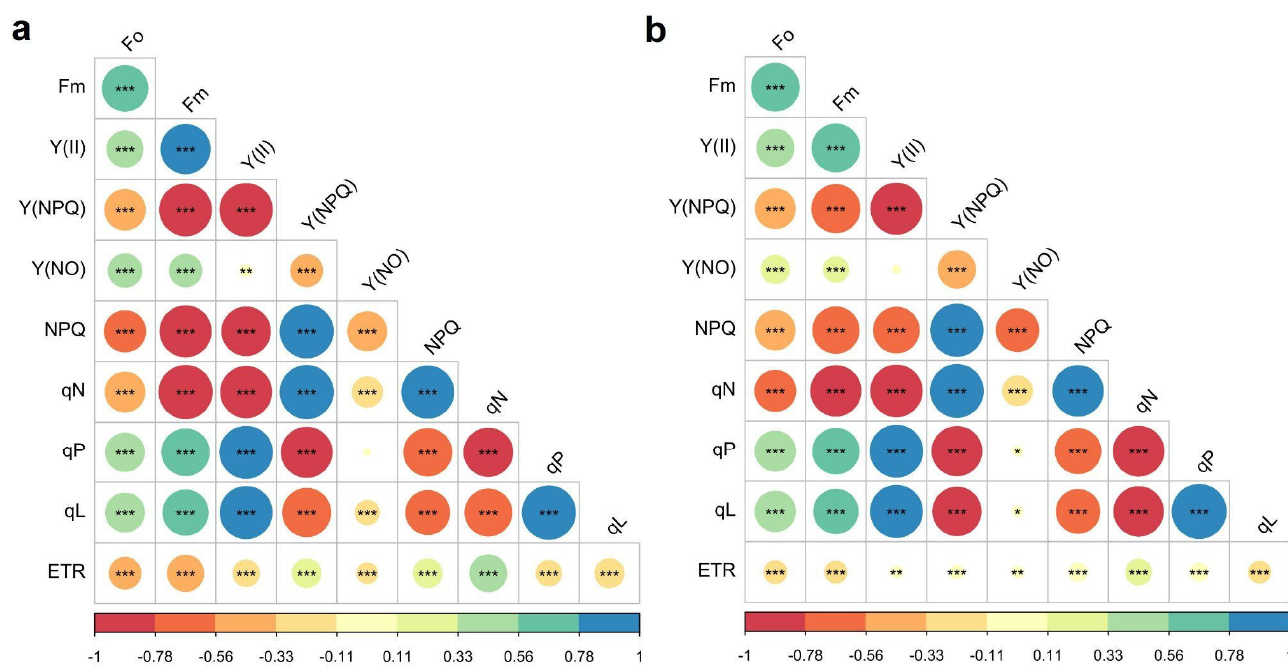
Figure 3. Relationships between different variables of chlorophyll fluorescence measured in Phaseolus vulgaris leaves. ( a ) Healthy leaves; ( b ) infected leaves. Maximal fluorescence (F m ), the effective quantum yield of photochemical energy conversion in PSII (Y(II)), quantum yield of regulated energy dissipation Y(NPQ), quantum yield of nonregulated energy dissipation Y(NO), non-photochemical quenching (NPQ), the non-photochemical quenching coefficient (qN), the coefficient of photochemical quenching (qP), coefficient of photochemical quenching (qL), and the apparent electron transport rate (ETR).